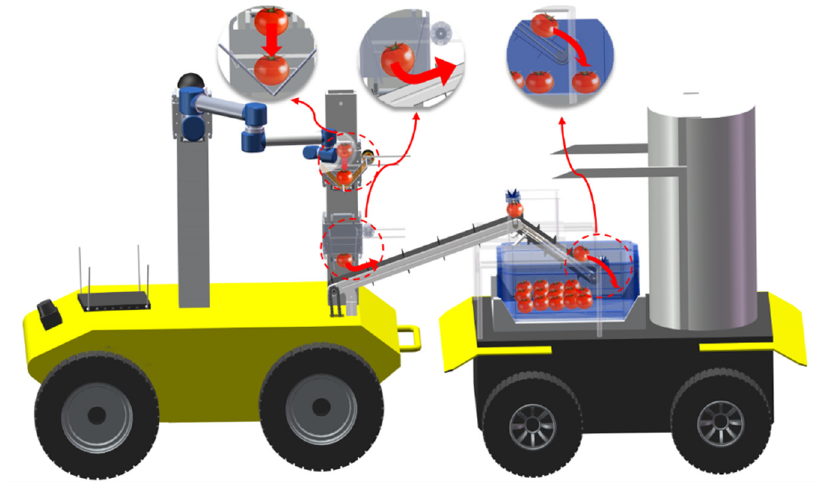
Figure 2. The moving route of tomatoes during the post-harvest process after picking.